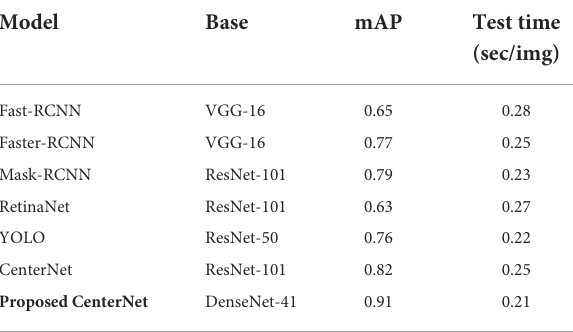
TABLE 5 Comparison with object detection models.